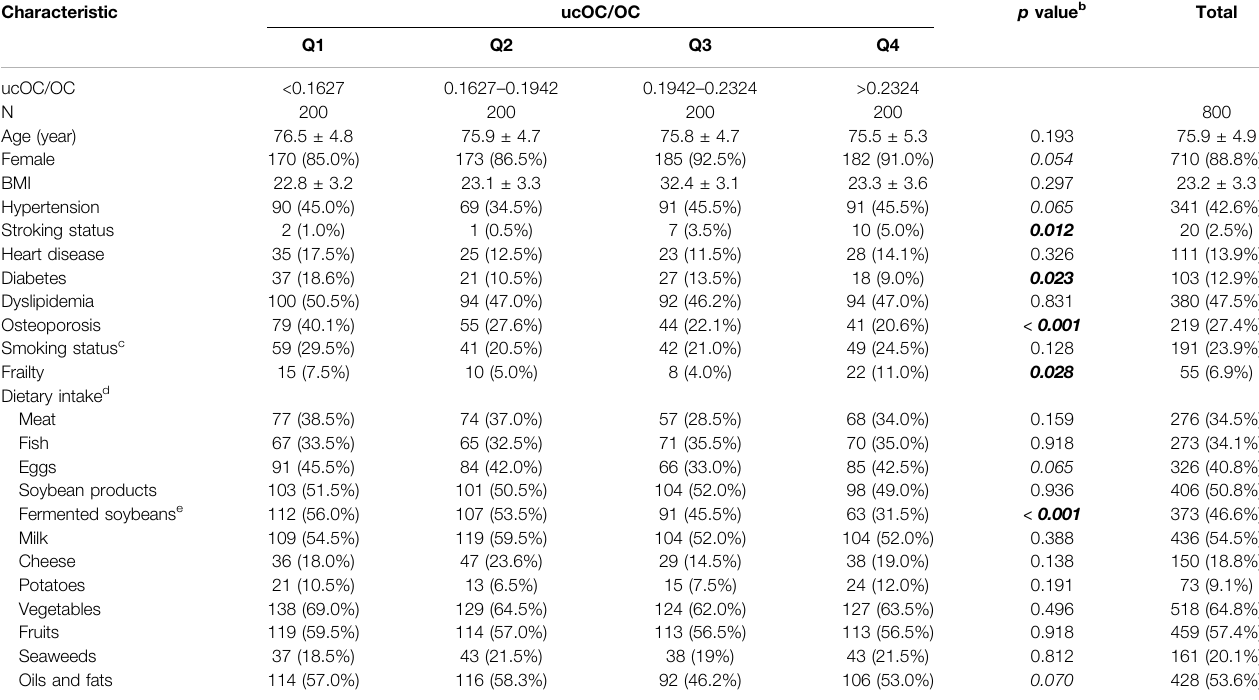
TABLE 1 | Characteristics of the study populations according to the levels of ucOC/OC a .